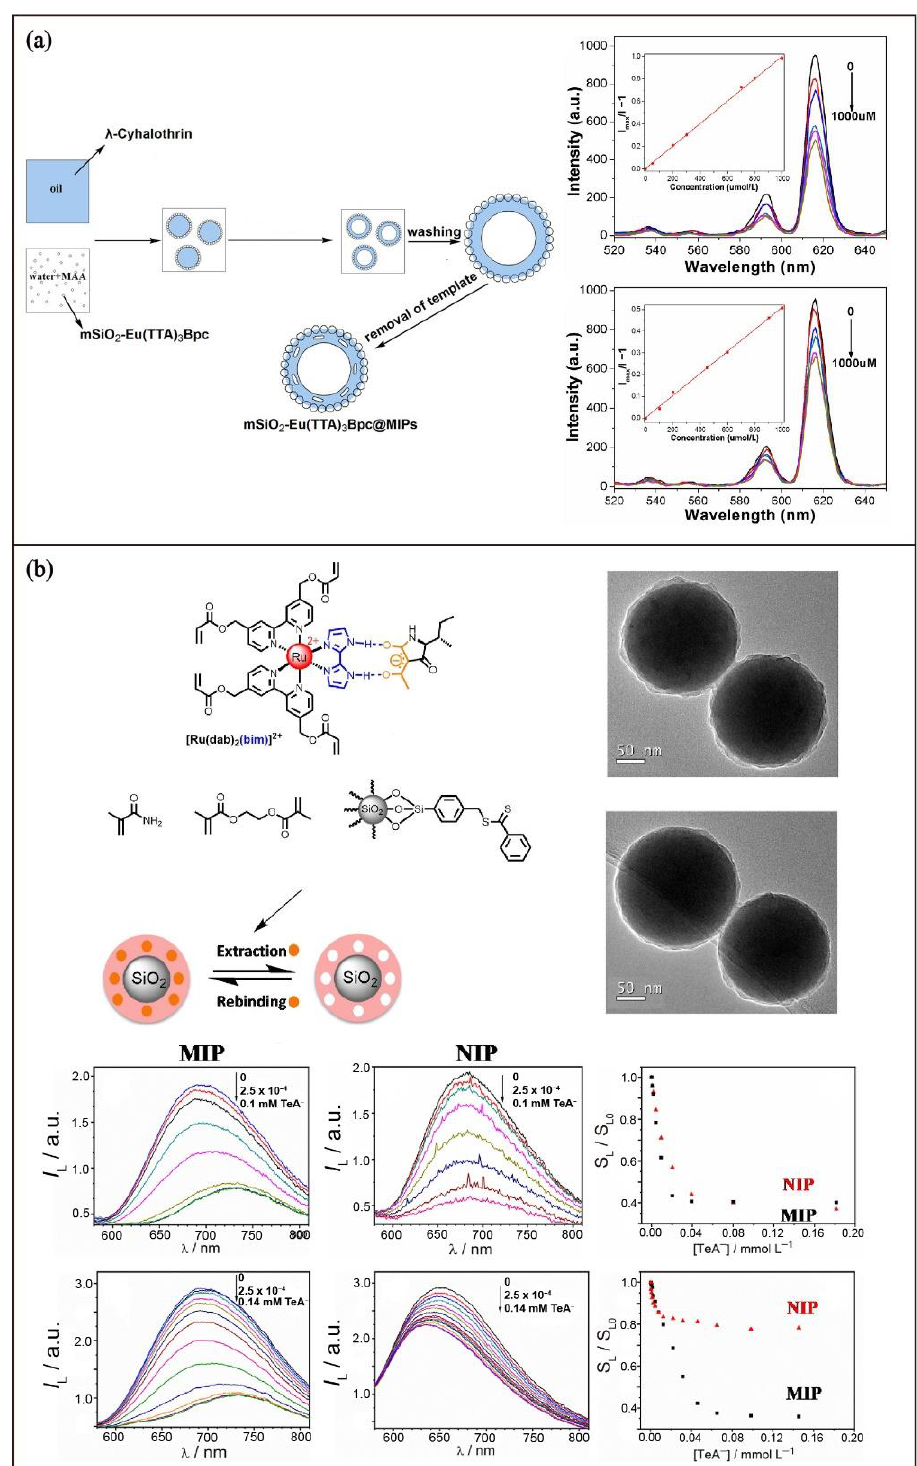
Figure 7. ( a ) Preparation of the silica-MIP modified with Eu(III) complexes and the emission quench- ing spectra of the MIP and non-imprinted polymer (NIP) for λ -cyhalothrin sensing. Adapted with permission [83]. Copyright 2013, American Chemical Society. ( b ) Fabrication of luminescent core- shell silica nanoparticle-MIP functionalized with Ru(II) complexes and the emission spectral changes in the tenuazonic acid sensing study. Adapted with permission [79]. Copyright 2021, Else-